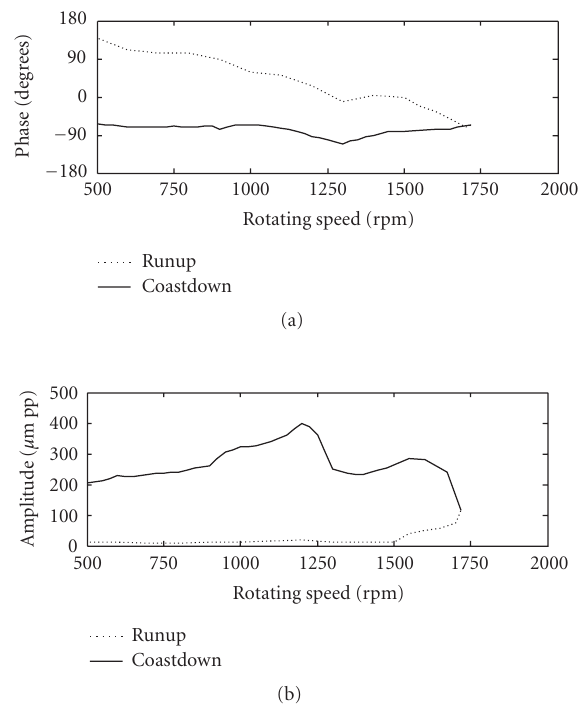
Figure 4: Bode plot of the 1X vibrations measured at bearing no. 2 during the first startup and the subsequent coastdown carried out after the rub